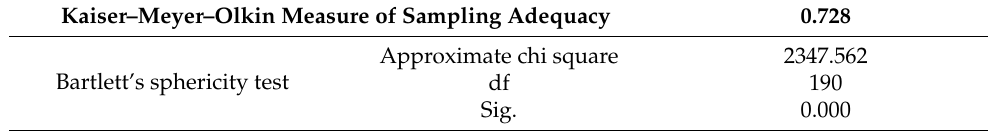
Table 1. Test results of KMO and